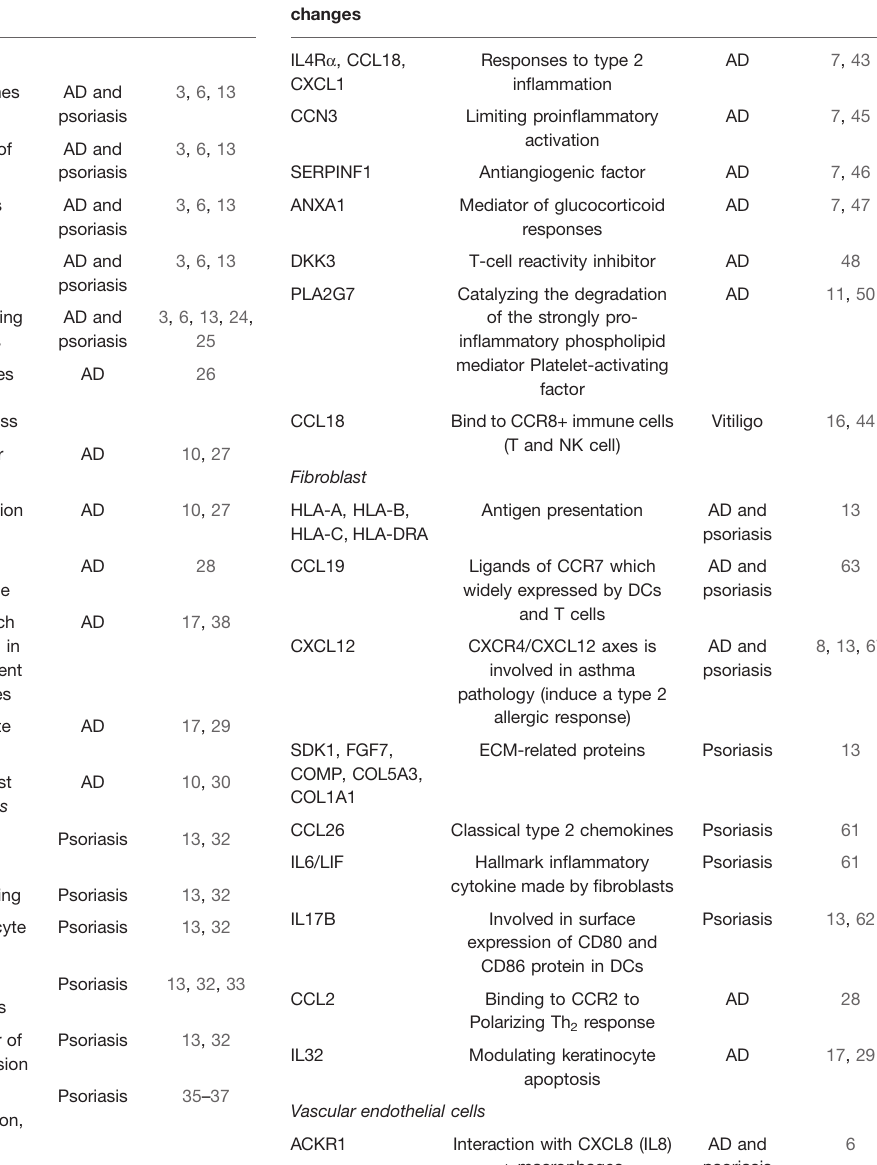
TABLE 2 | Molecule changes of skin resident cell in in fl amed